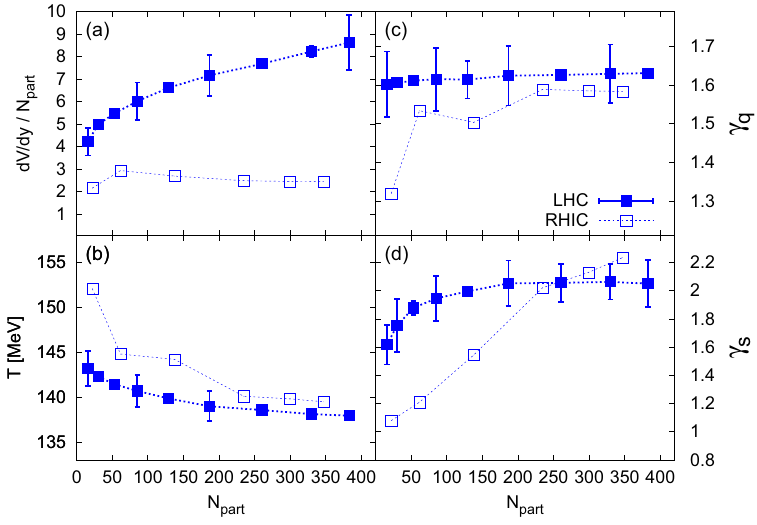
Figure 1. SHM parameters obtained at LHC-2760 compared to RHIC-62 as a function N part , the collision cen- trality. Volume normalized to number of participants in panel (a), freeze-out temperature T in panel (b), light quark phase space occupancy γ q in panel (c) and strangeness phase space occupancy γ s in panel